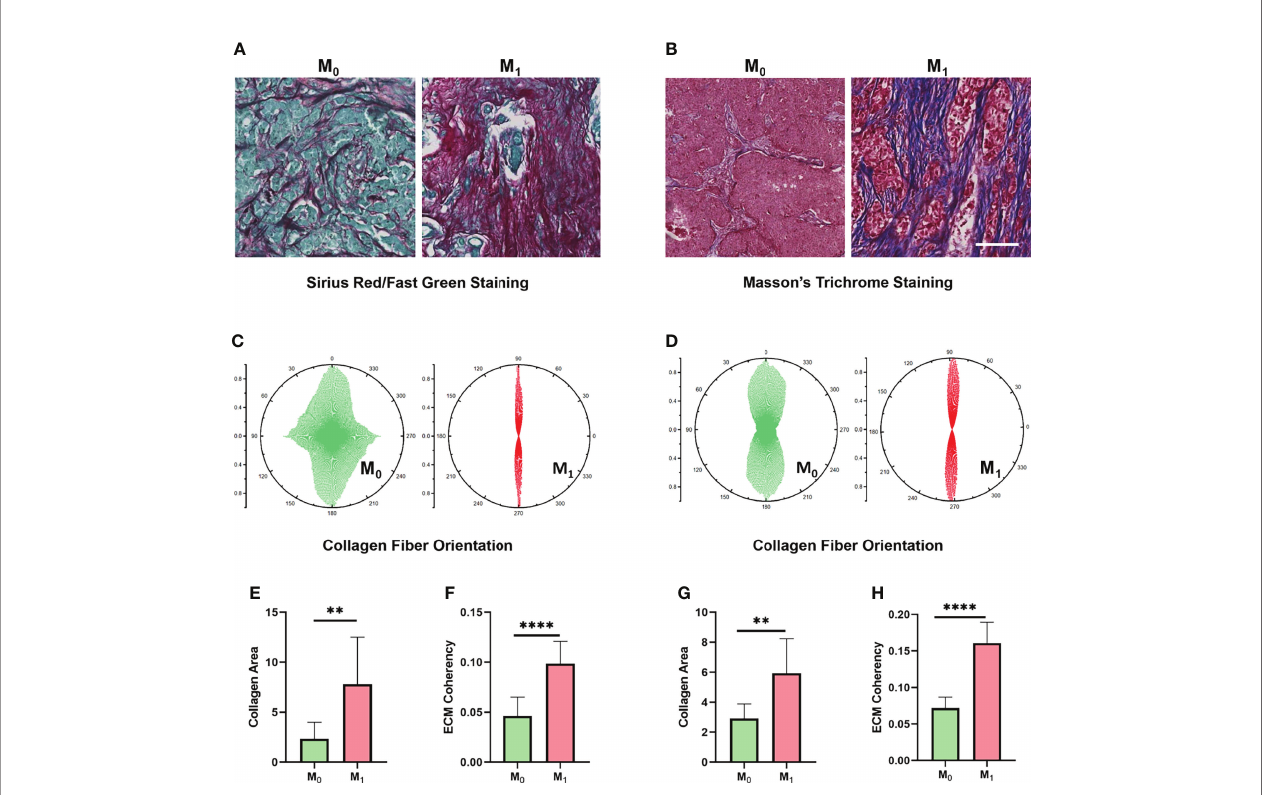
FIGURE 7 | ECM characteristics are associated with TNBC metastasis in clinical samples. (A) Sirius red/Fast Green staining images of different metastatic statuses. (B) Masson ’ s trichrome staining images between different metastasis statuses. (C) Orientation distribution of collagen fi brils between different metastasis statuses based on Sirius red/Fast Green staining. (D) Orientation distribution of collagen fi brils between different metastasis statuses based on Masson ’ s trichrome staining. (E) Area of collagen fi brils between different metastasis statuses based on Sirius red/Fast Green staining. (F) Collagen fi ber coherence between different metastasis statuses based on Sirius red/Fast Green staining. (G) Area of collagen fi brils between different metastasis statuses based on Masson ’ s trichrome staining. (H) Collagen fi ber coherence between different metastasis statuses based on Masson ’ s trichrome staining. (scale bar, 100 m m). ** p < 0.01, **** p <